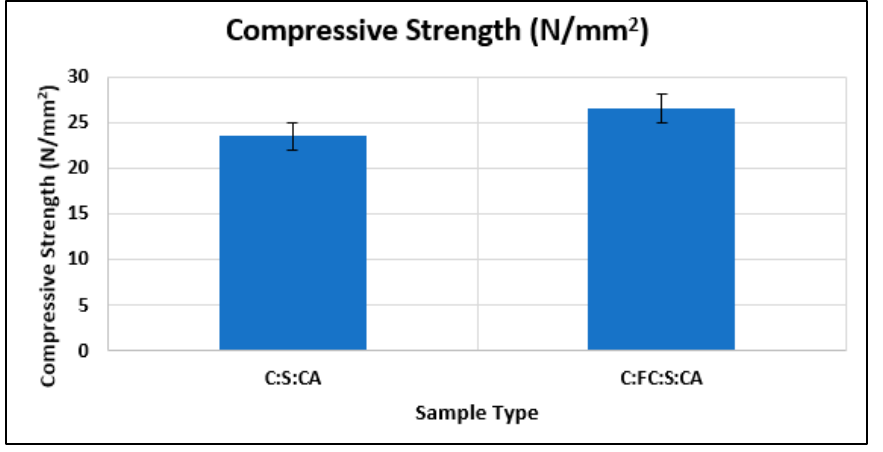
Figure 19. Comparison of test results of concrete cubes with cement and 25% fine cement.